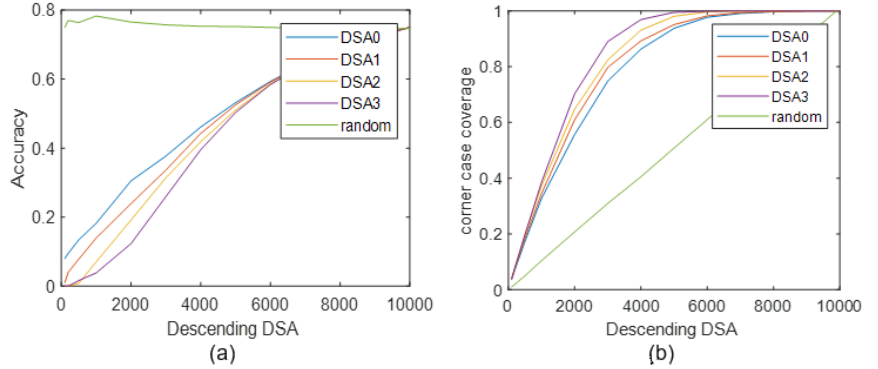
Figure 11. Performance of corner case detection in CIFAR10. ( a ) Accuracy ( b ) Corner case